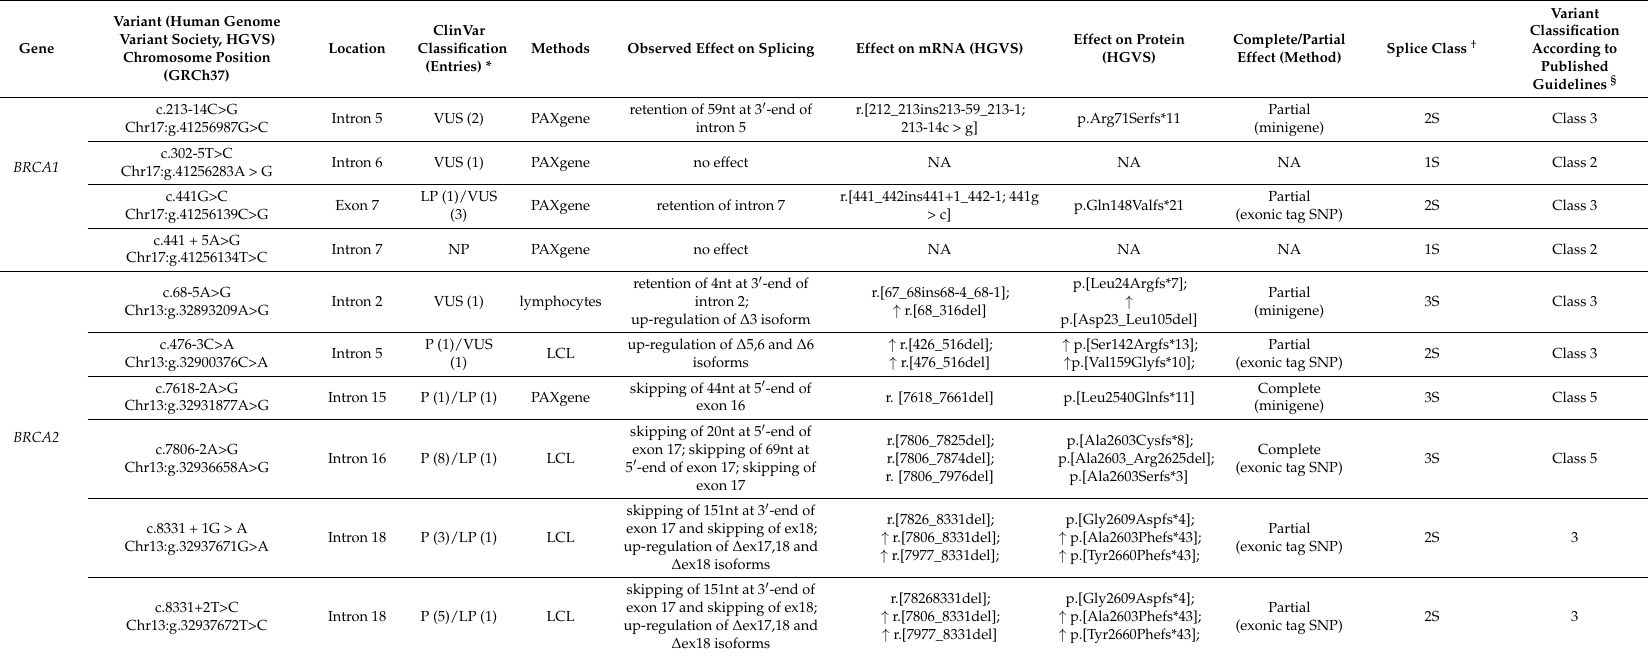
Table 1. mRNA splicing effects of identified variants and predicted effect on